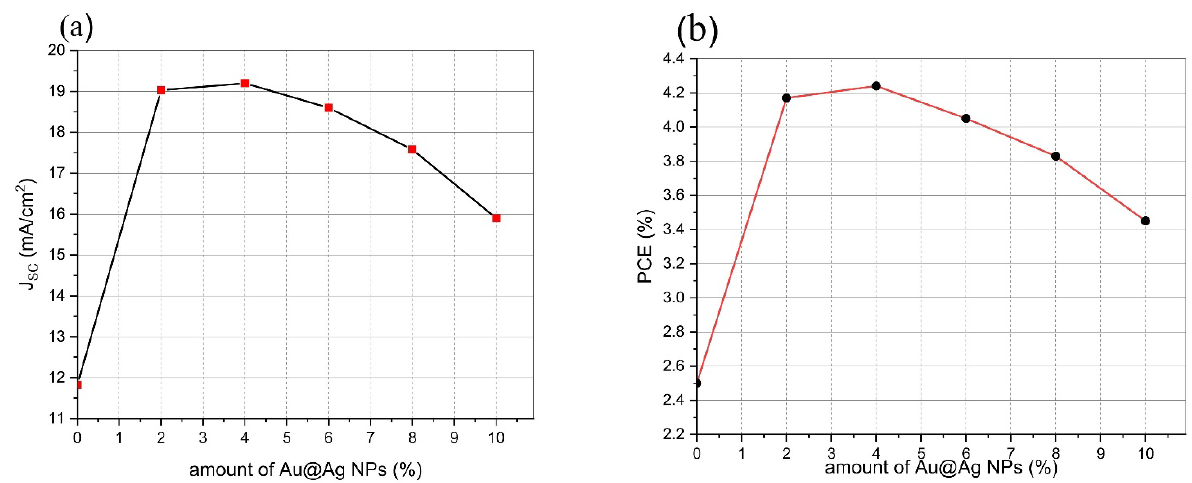
Figure 7. ( a ) J sc and ( b ) PCE of solar cells with and without NPs. Table 2. Summary of previous research on plasmonic MNPs and their corresponding PCE im- provements.